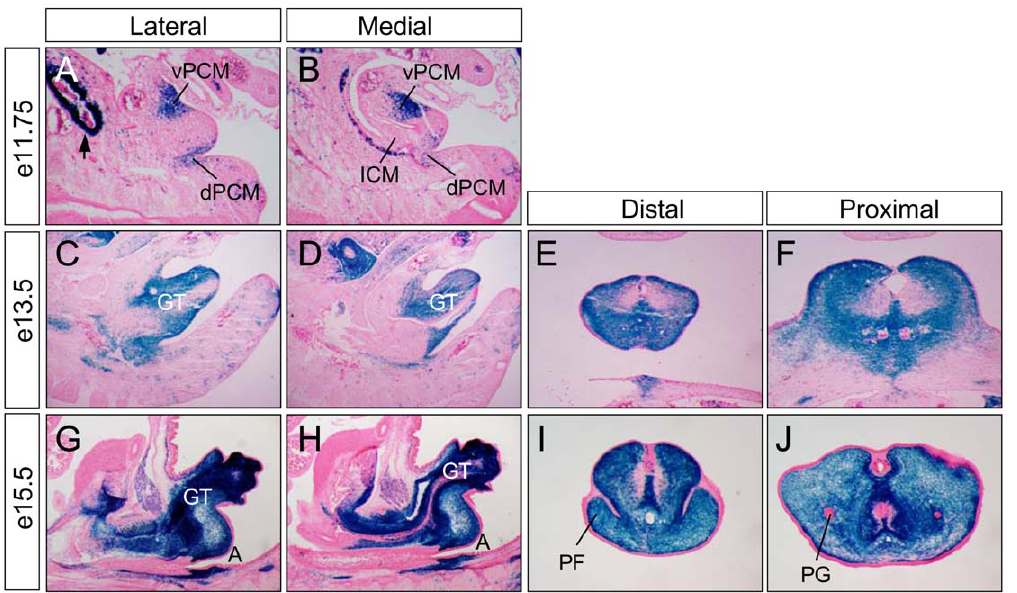
Figure 2. A genetic fate map of Six2- expressing PCM progenitors. X-gal staining (blue) of sagittal ( A–D , G and H ) and cross ( E , F , I , J ) sections from e11.75, e13.5 and e15.5 Six2 GC/ + ;R26R LacZ double heterozygous embryos. All sections were counterstained with eosin (pink). A, anus; PG, preputial gland; see Figure 1 for more abbreviations.